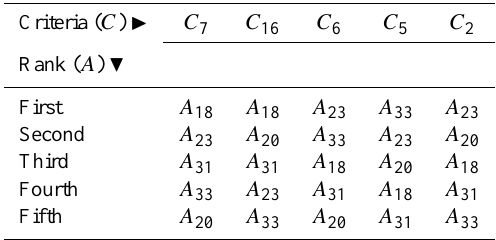
Table 13. Matrix of alternative ranking.